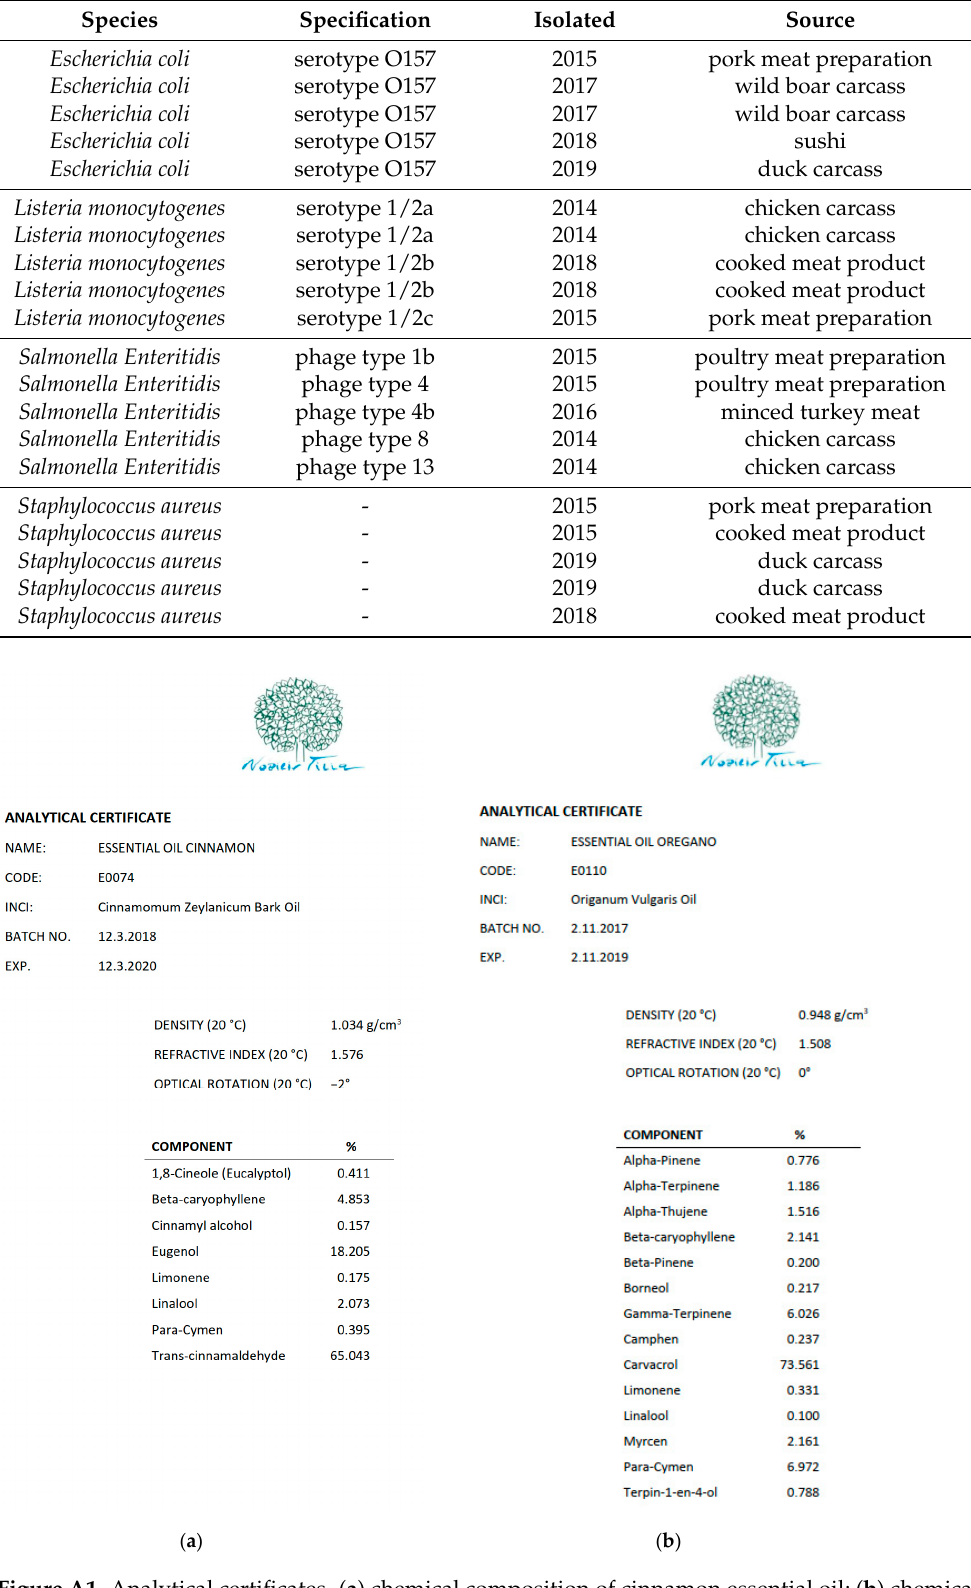
Table A1. Bacterial isolates used in the study.